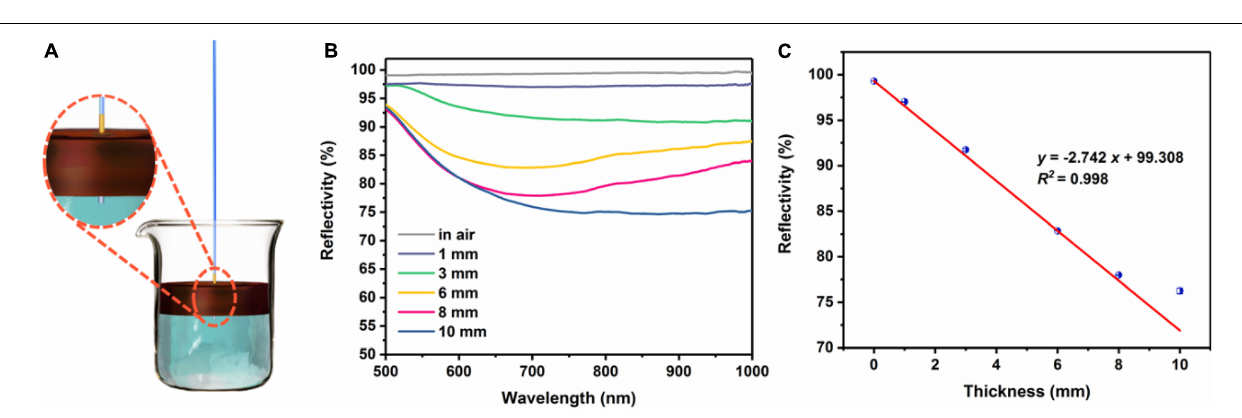
iron and zinc. However, as the optical fiber SPR sensor is made of glass and has a gold layer with corrosion resistance, it does not encounter this